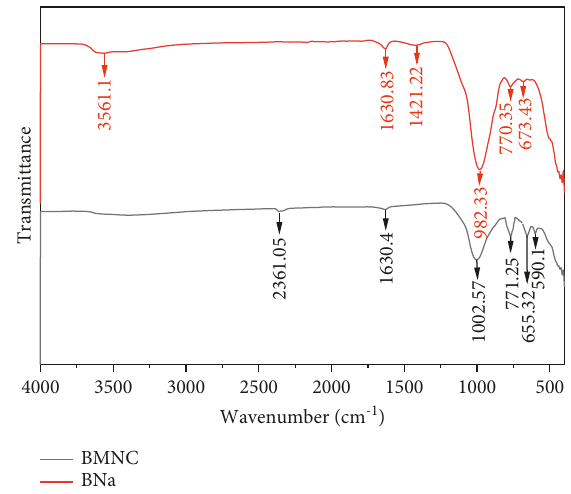
Figure 3: FTIR spectra of bentonite (BNa) and the nanocomposite adsorbent